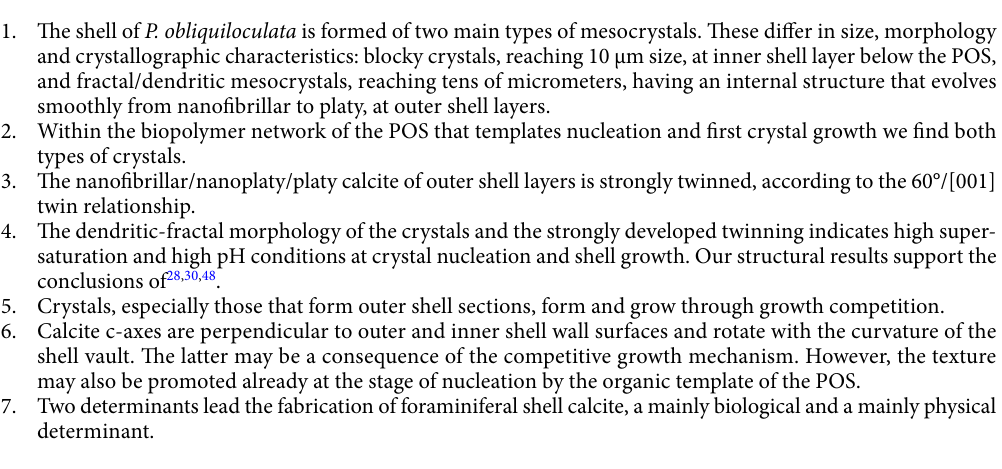
Figure 11. Development of crystal co-orientation strength from inner to outer shell wall layers on a cross- section through the shell wall of Pulleniatina obliquiloculata . ( a )–( e ) The white arrows in the EBSD band contrast measurement images (in grey) indicate the relevant section of a cone-shaped unit (in color) that was taken as a subset. The corresponding pole figures, given in ( a )–( e ), show crystal orientation data of these subsets only. ( a ): Shell wall portion at the POS and the shell section that is formed of the blocky crystals; ( e ): Shell wall section close and at the cortex. Crystal co-orientation strength is given with the MUD value. We find: (1) an increase in MUD, accompanied by a decrease in amount of crystals from the POS/blocky crystals ( a ) to the cortex ( e ), (2) however, at keeping a similar/comparable texture pattern for all the subsets. This indicates that the crystallographic axes orientation of the crystals is already determined within the POS, by the polymer network of the POS and that the texture of the crystals is not only given and initiated by the competitive growth